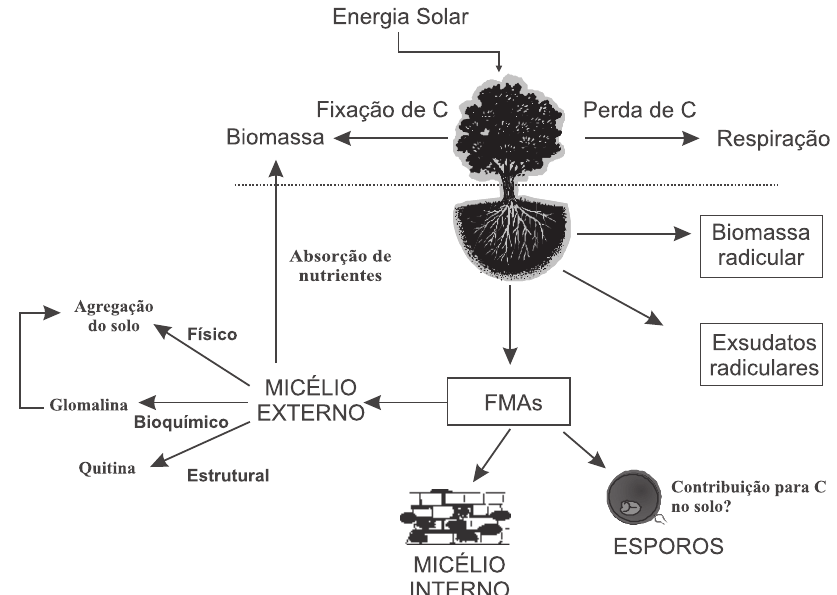
Figura 1. Modelo dos fluxos de carbono entre o solo e a atmosfera, enfatizando o papel das estruturas formadas pelos fungos micorrízicos arbusculares (FMAs) na fixação de carbono no solo. (Modificado de zhu & Miller,